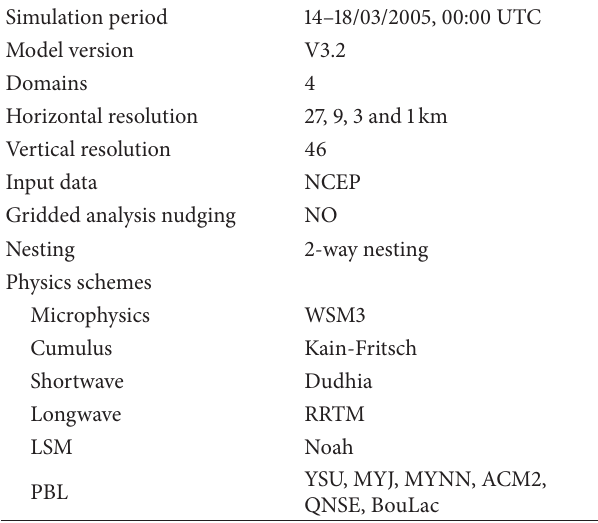
Figure 5: Taylor diagram displaying a statistical comparison with fourWRFmodelestimates(YSU:1,MYJ:2,MYNN:3,andACM2:4) of the wind speed during the stable period 16–18 March 2005. Red is the EDF statistics and blue is the Mu˜noz-Esparza et al. [8] statistics.